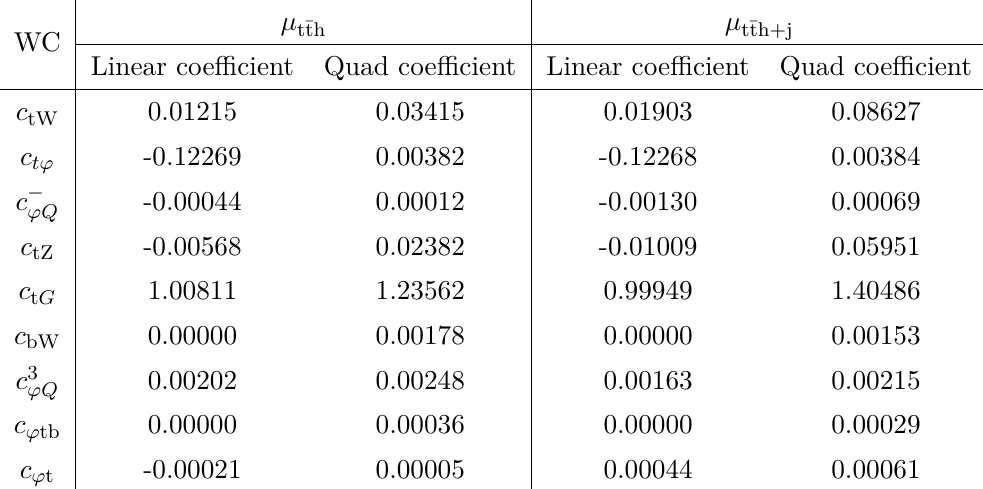
Table 5 . Summary of quadratic fit coefficients for the t¯th parameterization for µ t¯th and µ t¯th+j . As discussed in the text, the cross sections are normalized to the